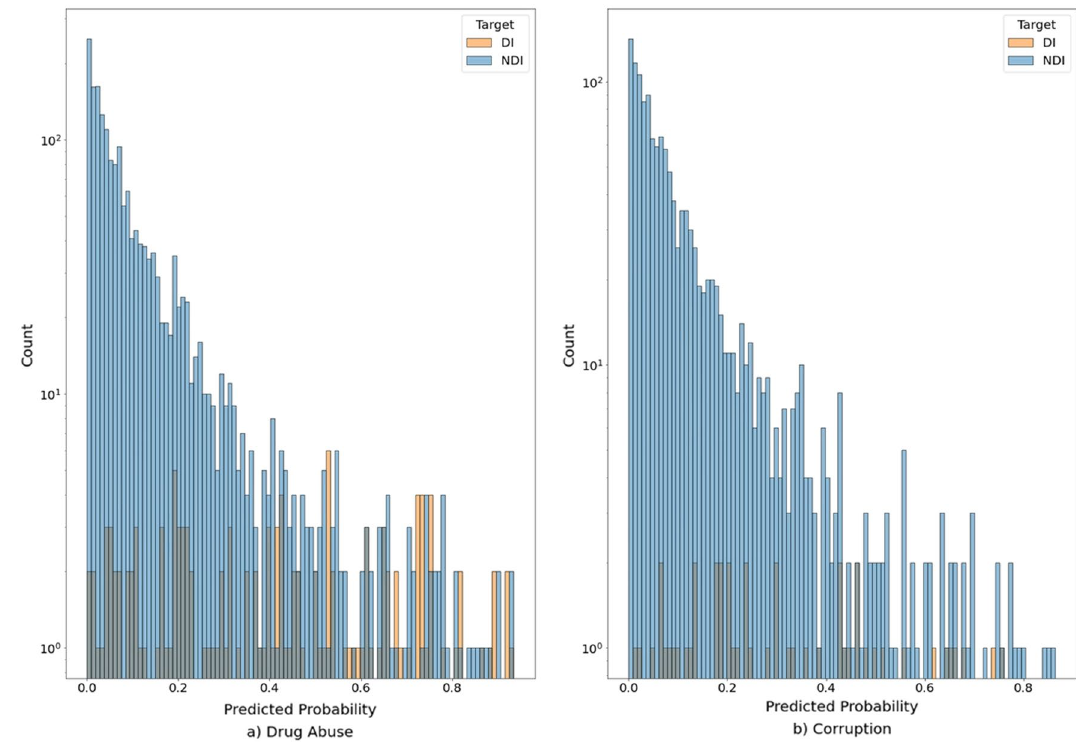
Figure 2. Distribution of basic model scores for topics: ( a ) “Drug abuse”; ( b )